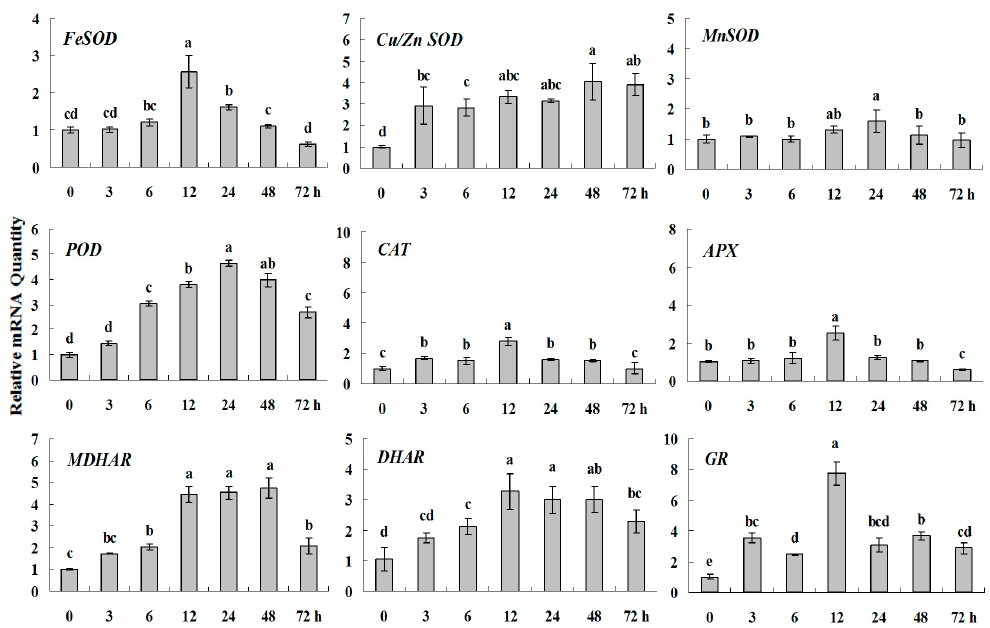
Figure 2. Quantitative real-time RT-PCR was used to analyze of ROS-scavenging enzyme genes expression during cold stress and normalized to β -Actin . White clover leaves were sampled after 0, 3, 6, 12, 24, 48 and 72 h treatment. Data represent means of three replicates. Error bars representing standard errors and the different letters above the bars represent significant difference ( p < 0.05).